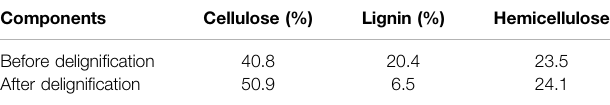
TABLE 1 | Components of Pennisetum hydridum before and after deligni fi